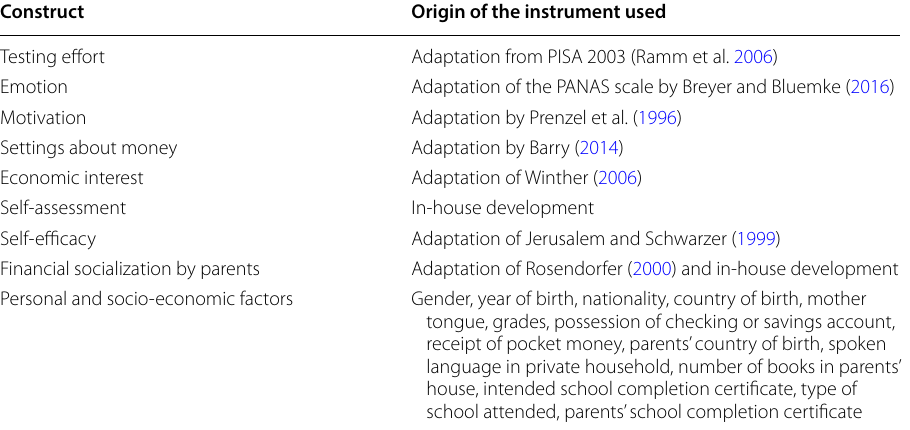
Table 1 Instruments used to record relevant predictors (Rudeloff 2019) Construct Origin of the instrument